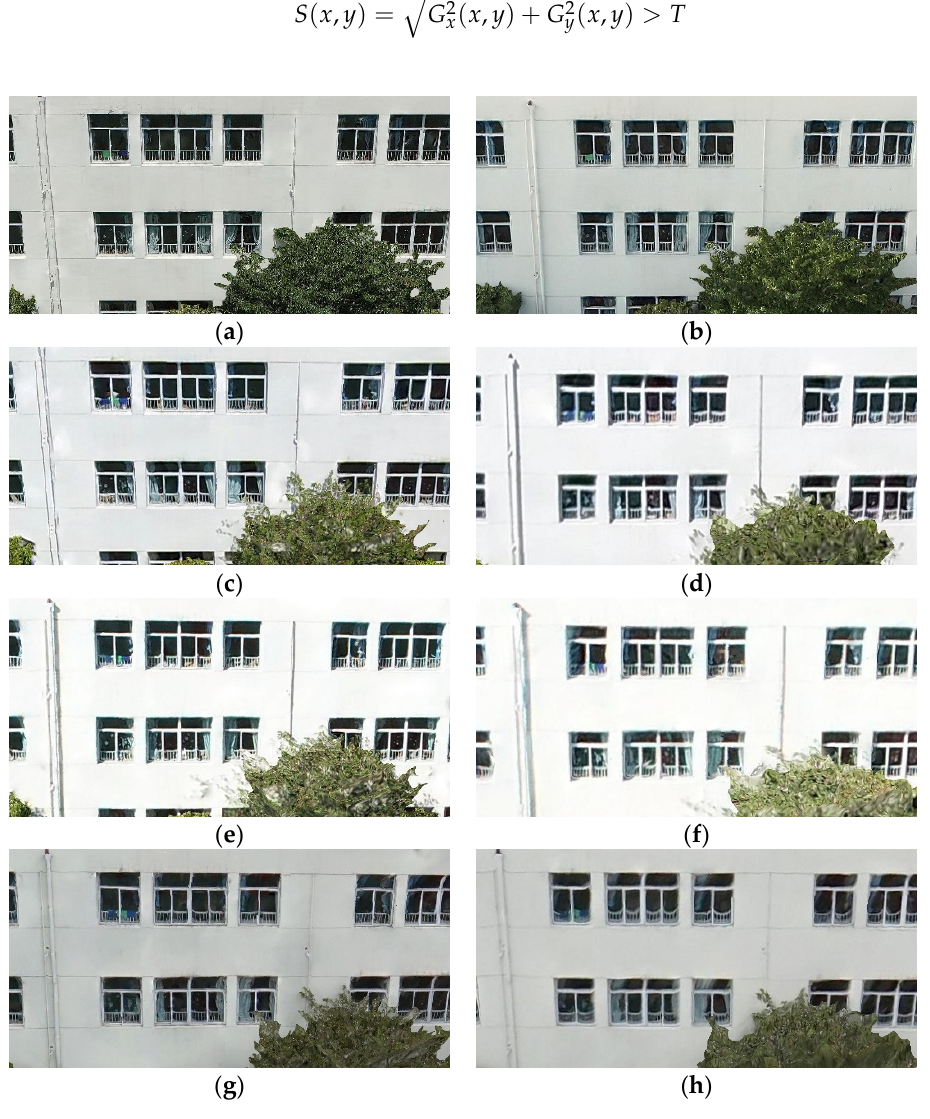
Figure 6. Side texture of the 3D reconstruction model. ( a ) M300RTK 50 m height. ( b ) M300RTK 90 m height. ( c ) Inspire2 50 m height. ( d ) Inspire2 90 m height. ( e ) Phantom4Pro 50 m height. ( f ) Phantom4Pro 90 m height. ( g ) M600Pro 50 m height. ( h ) M600Pro 90 m height.